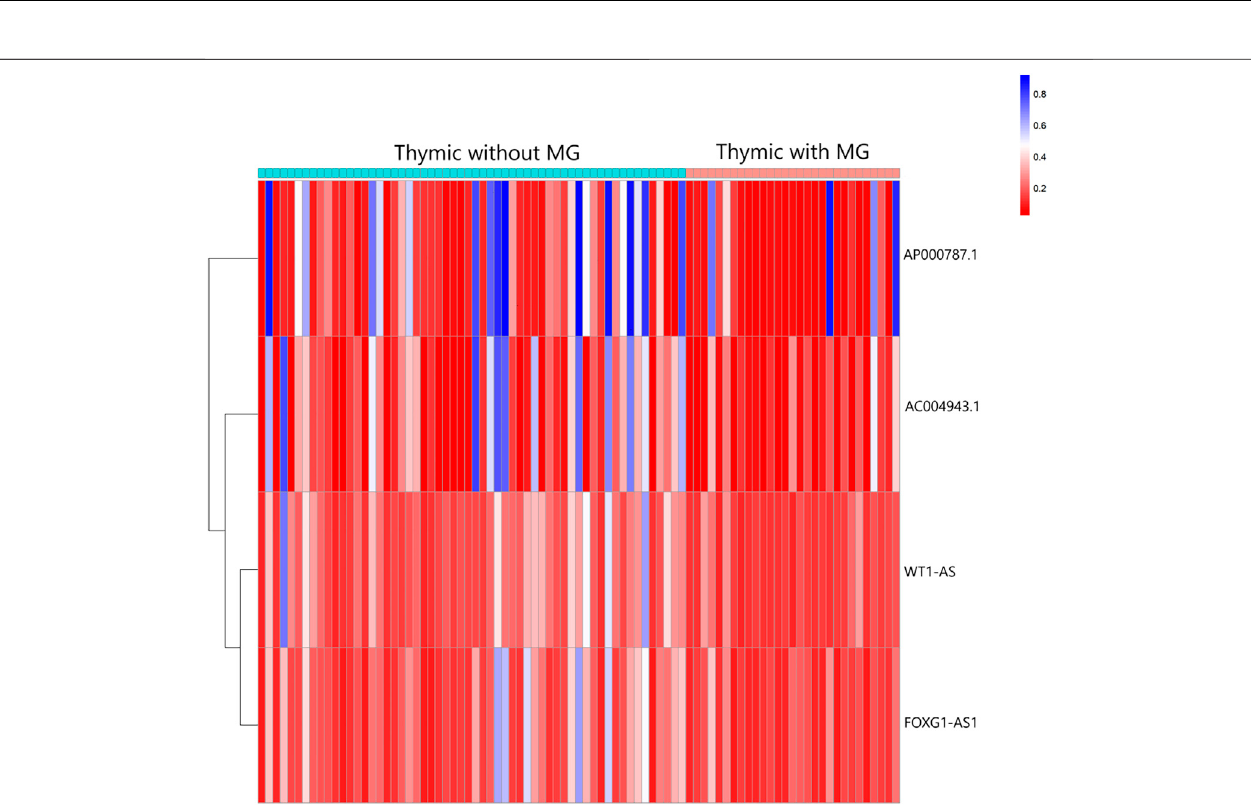
FIGURE 2 | Heatmap analysis of DNA methylation in immune-related lncRNAs in patients with thymoma with MG and patients without MG.